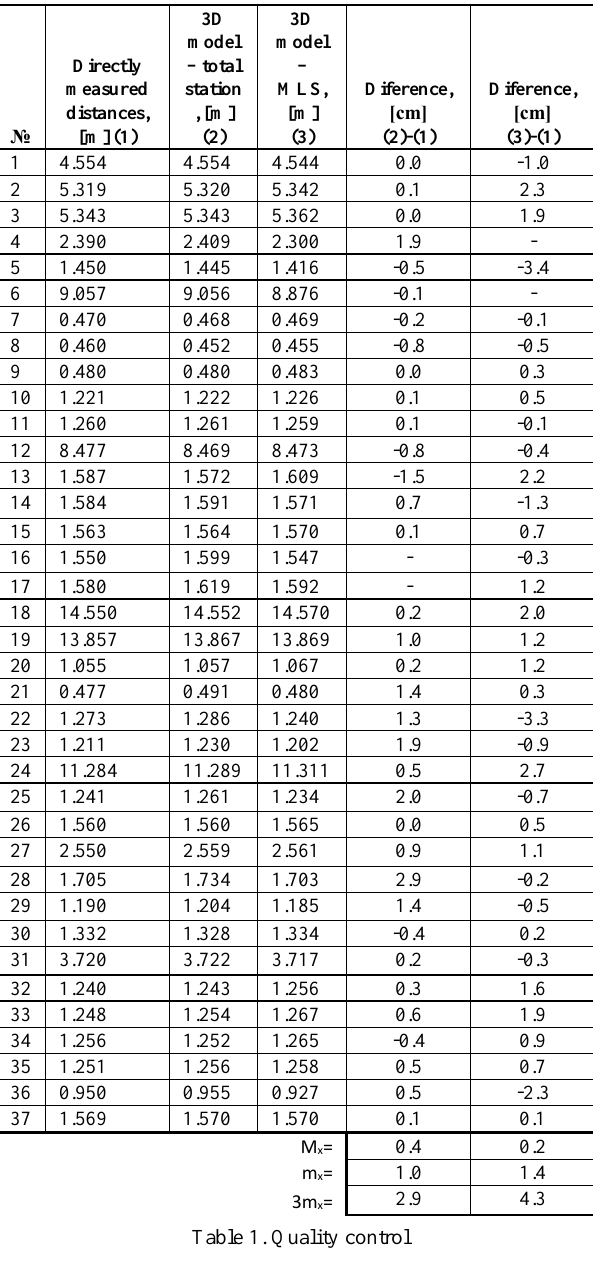
Table 1. Quality